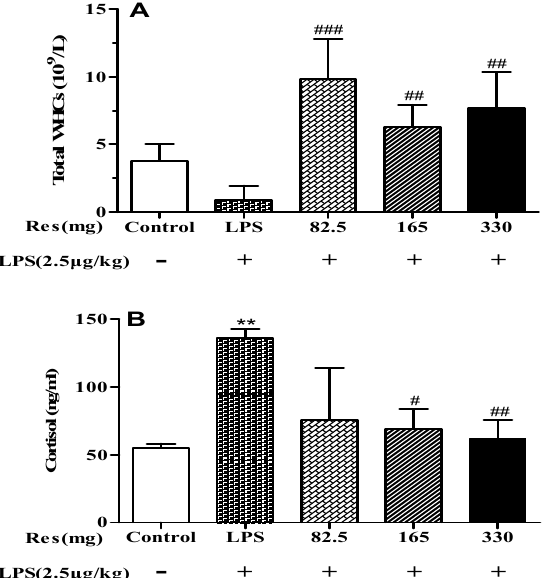
Figure 4. E ff ect of resveratrol on: ( A ) the number of total white blood cells (WBCs) and ( B ) concentration of plasma cortisol in LPS-challenged lambs. Values are normalized to control values and expressed as means ± SD. * p < 0.05, ** p < 0.01, and *** p < 0.001, compared with the control group; # p < 0.05, ## p < 0.01, and ### p < 0.001, compared with the LPS treatment.